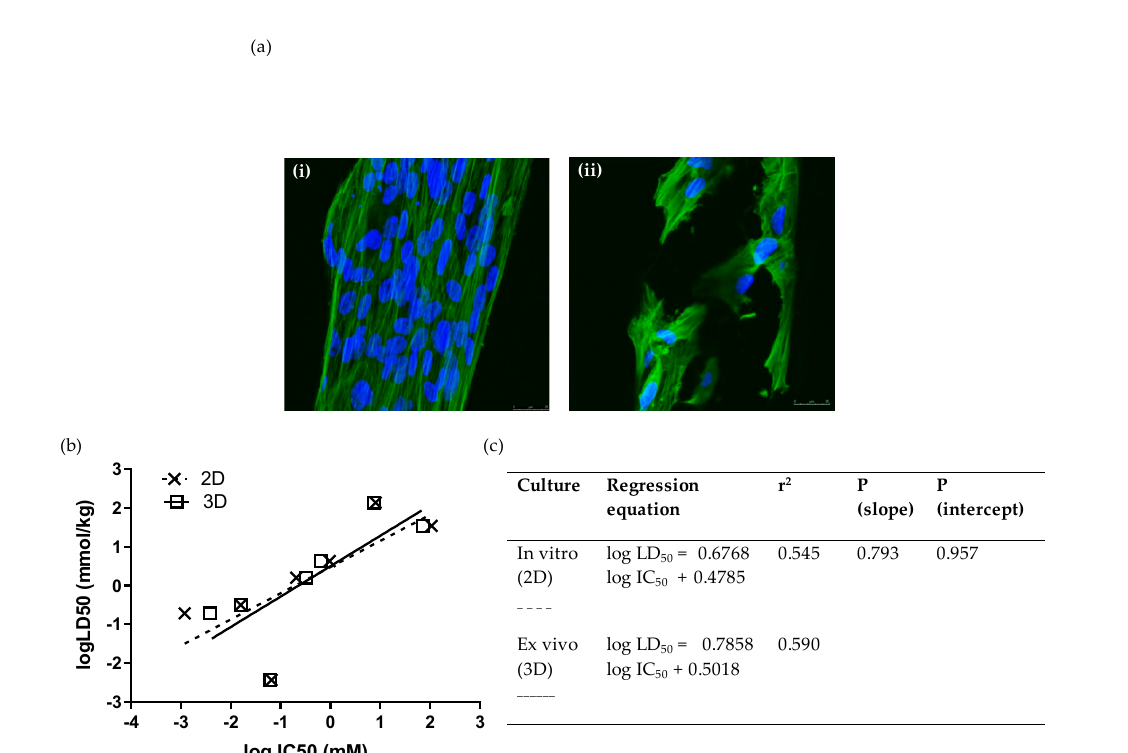
Figure 2. Ex vivo cytotoxicity screening of 7 selected chemicals on 3D scaffolds by means of the WJSC-MTS assay: ( a ) Growth and morphology of WJSCs in the 3D microenvironment of the inert polystyrene (PS) scaffold. Panels show representative composite confocal micrographs of WJSCs growing on the periphery of the microtubules comprising the scaffold meshwork ( i ) in the presence of growth medium (GM) only (control), or ( ii ) in GM containing a concentration of NaF close to its IC 50 . Each composite image was derived by merging 10 confocal micrographs taken across the tube diameter at 1.5 um steps (z-series). Mag = 40×, Mag bar = 25 uM; blue = DAPI nuclear staining; green = phalloidin staining of the actin cytoskeleton. ( b , c ) Comparison of linear regressions of human fetal WJSCs cultured on conventional tissue-culture-treated plastic (polystyrene (PS)) surface (2D culture), and in three-dimensional inert scaffolds with a rectangular mesh structure (PS inserts).